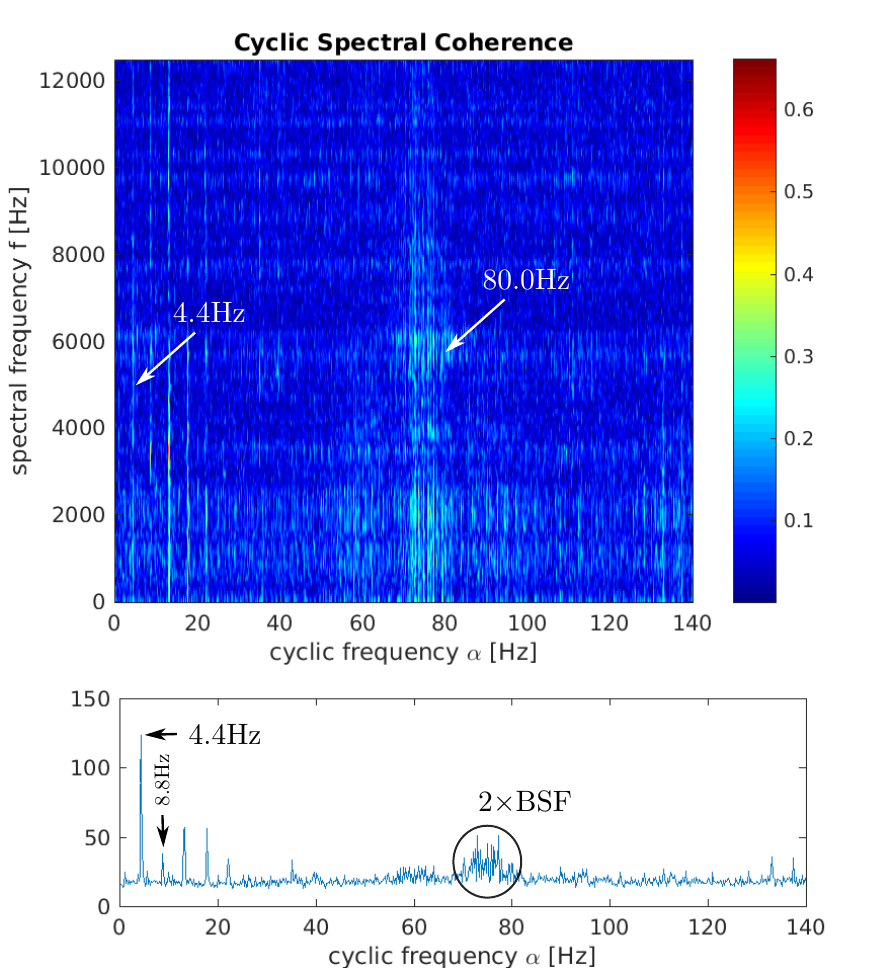
Figure 7. Cyclic Spectral Coherence of the second bearing with roller defect; top figure shows the 2 × BSF frequency (80.0 Hz) and the FTF (4.4 Hz) frequency and the bottom figure is the integration of the top figure along frequency